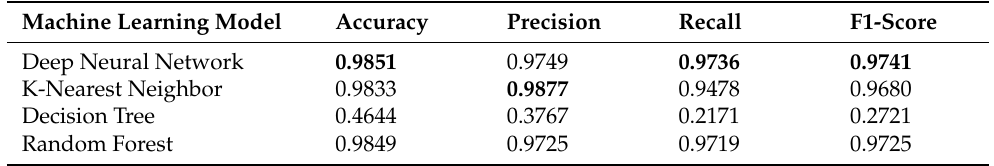
Table 18. Overall classification report of different machine learning models for aphasia severity level classification using audio features extracted using MFCC for 10 s audio